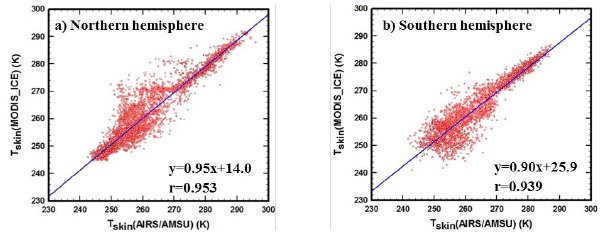
Fig. A3. Scatter diagrams for the 9-day composite of T skin (MODIS ICE) versus T skin (AIRS/AMSU) over the (a) Northern Hemisphere during the days 106–114, 2003, and (b) Southern Hemisphere during the days 258–266, 2003. The values of AIRS/AMSU and MODIS have been compared to each other in a 1 ◦ × 1 ◦ grid